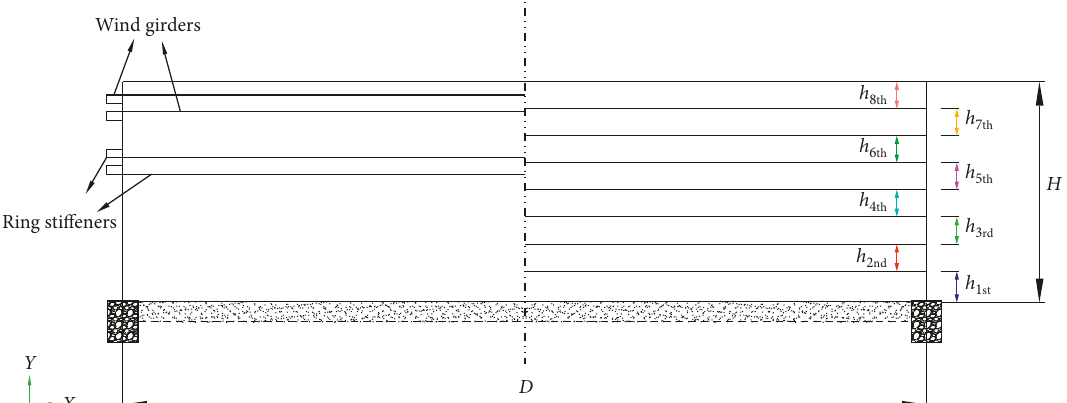
10 4 m 3 storage capacity. ×